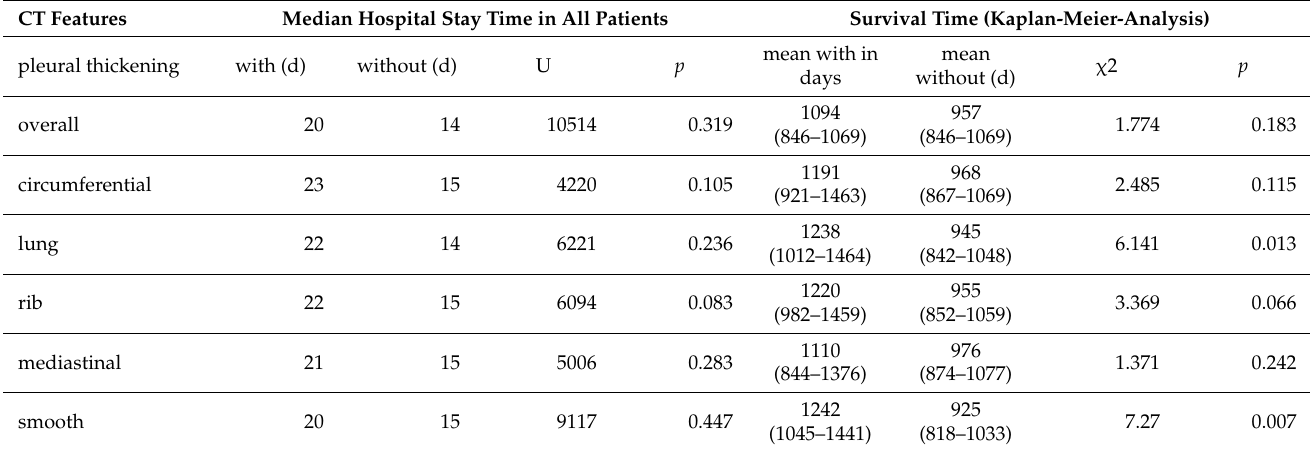
Table 3. Radiology and